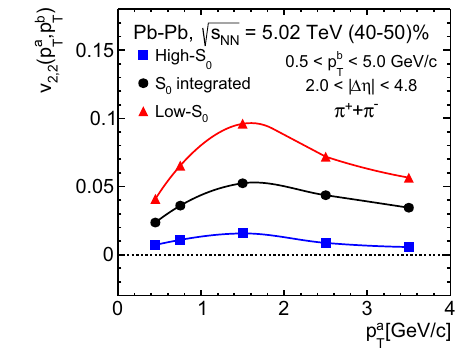
Fig. 4 Two particle elliptic flow coefficients of pions for low- S 0 (red triangles), high- S 0 (blue squares) and spherocity-integrated (black cir- cles)eventsin(40–50)%centralPb+Pbcollisionsat